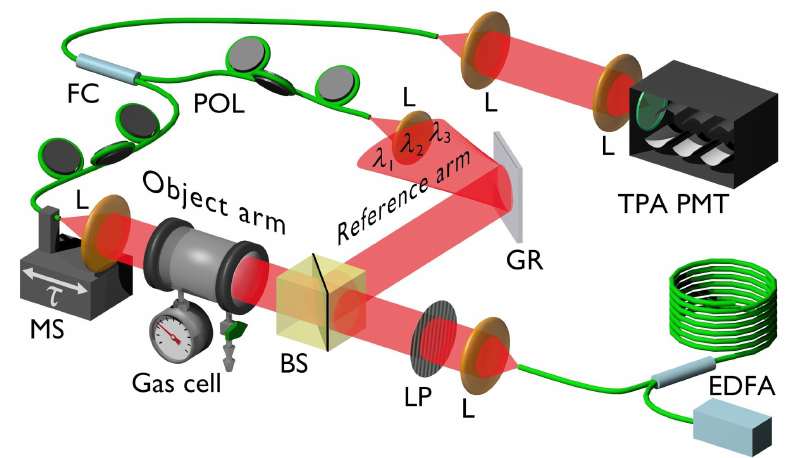
Figure 1. Schematic diagram of the experimental setup for the ghost spectroscopy (GS) experiment: The setup comprises the amplified spontaneous emission continuous-wave light source of an erbium-doped fiber amplifier (EDFA), collimating and focusing achromatic lenses (L), a fixed linear polarizer (LP), a non-polarizing beamsplitter (BS), a fixed reflective diffraction grating (GR) followed by a movable fiber coupling unit in the reference arm, thus enabling wavelength resolution, a high pressure gas cell filled with C 2 H 2 within the object arm, again followed by a fiber coupling unit, a single-mode fiber-based combiner (FC), a motorized linear translation stage (MS), polarization controlling elements (POL), lenses for focusing the light onto the photocathode of the PMT ( H7421-50, Hamamatsu Photonics, Hamamatsu, Japan) operated in Two-Photon-Absorption (TPA) mode and a longpass filter (LPF Schott RG1000, Schott, Mainz, Germany) preventing visible light from entering the detector.